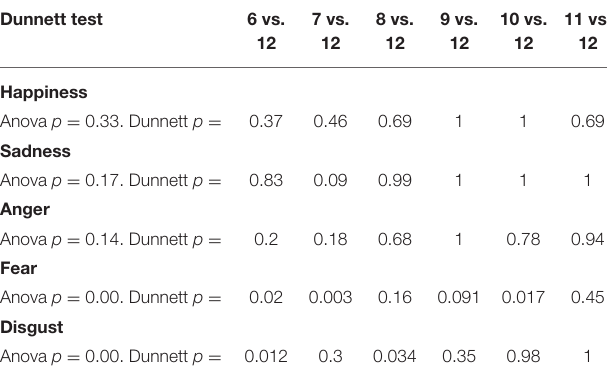
TABLE 3 | Comparison of significance of the age variable by